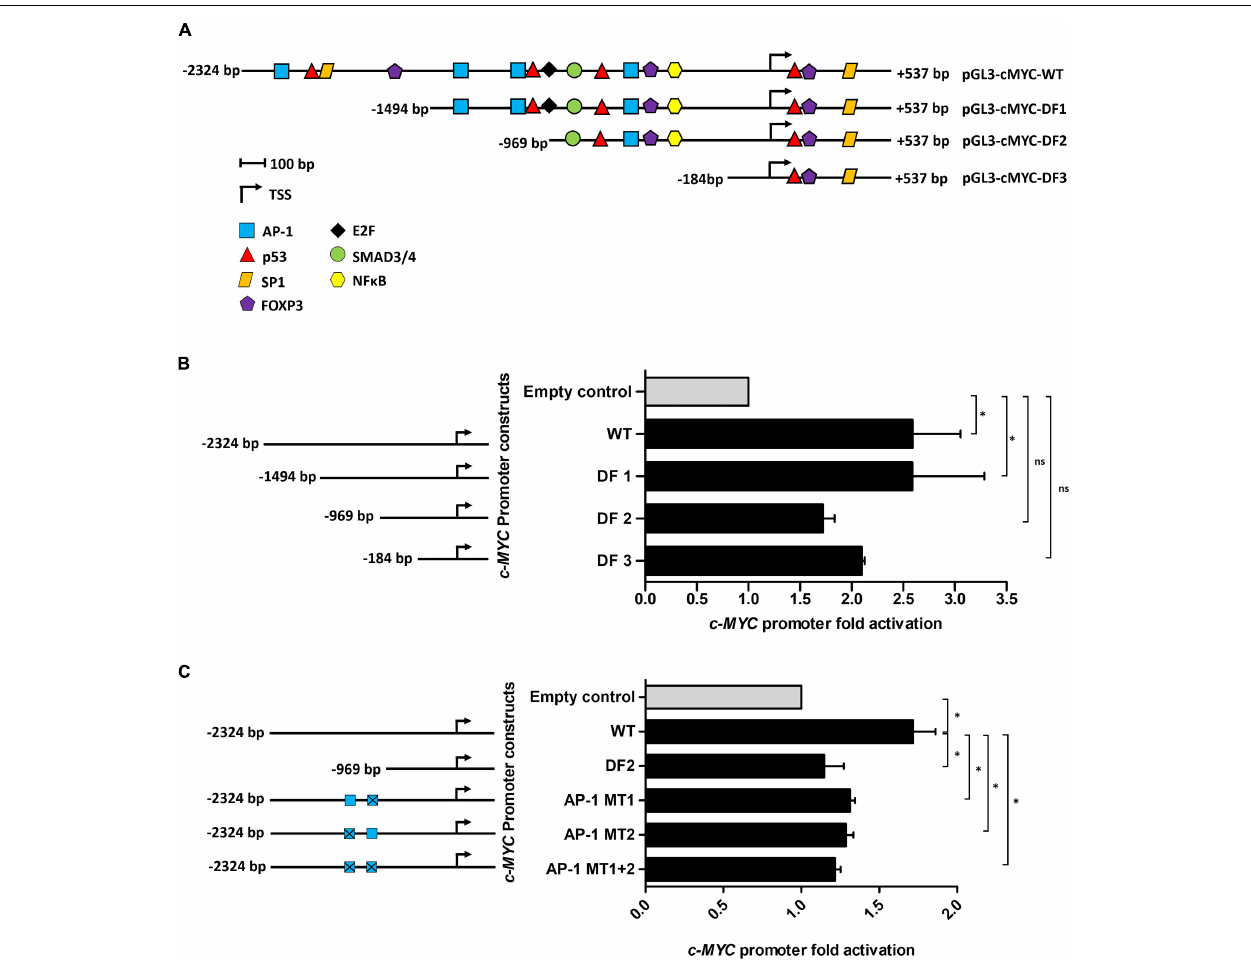
FIGURE 2 | The AP-1 sites located at positions -1128 and -1375 bp partially mediate the effect of HIV-1 Tat on the c-MYC promoter. (A) The WT c-MYC promoter (-2324 to + 537 bp) construct was analyzed for TFBS using PROMO. Sites are represented as different colored shapes which are labeled in the key and the transcription start site (TSS) is denoted by a black arrow. Shortened promoter constructs are labeled accordingly on the right side of the diagram (pGL3-cMYC-DF1, pGL3-cMYC-DF2 and pGL3-cMYC-DF3). (B) Luciferase reporter assays comparing the fold activation of the c-MYC WT promoter to the deletion constructs (DF1-DF3) in the presence of HIV-1 Tat. (C) Luciferase assays comparing fold activation in the presence of HIV-1 Tat between the WT promoter, DF2 and AP-1 MT1, AP-1 MT2 and AP-1 MT1 + 2 constructs. Fold activation was obtained by comparing the relative luciferase units (RLU) of the pcDNA-Tat transfected groups to